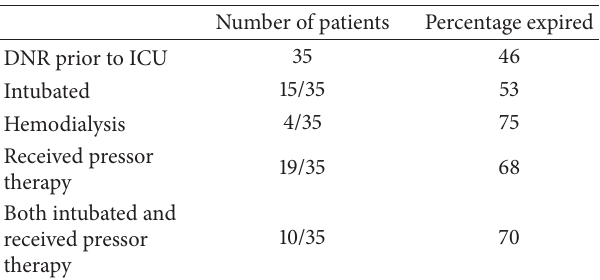
Table 2: ICU care and outcome of patients who were DNR prior to admitting to an